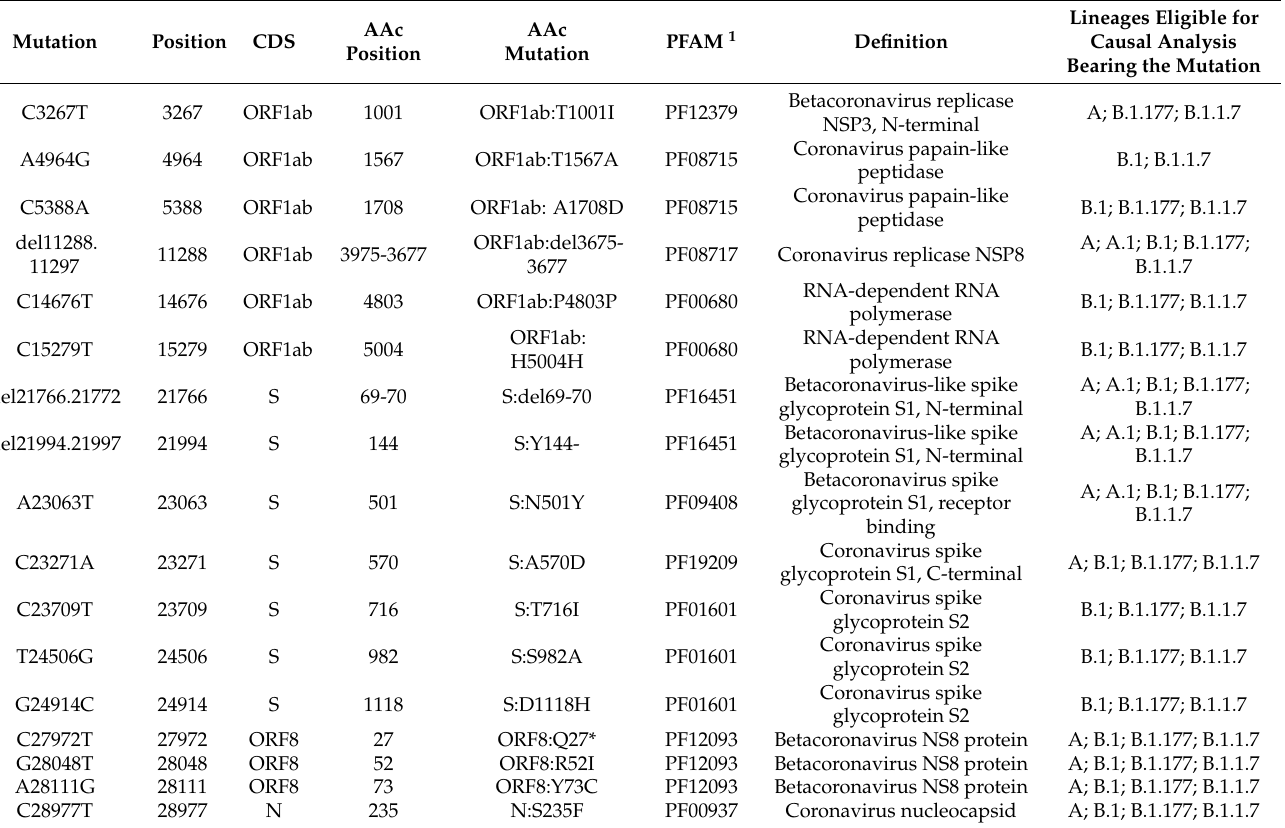
Table 2. Mutations associated with higher patient mortality that affect PFAM motifs and pangolin lineages eligible for causal analysis with the mutation (non-synonymous from outbreak.info [68] and synonymous from cov-spectrum.org